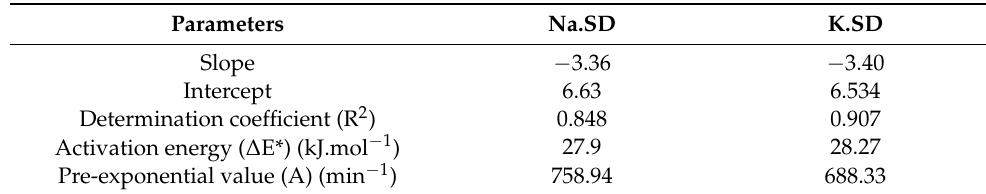
Table 4. The activation energy and pre-exponential values of the performed transesterification reactions using Na.SD and K.SD.